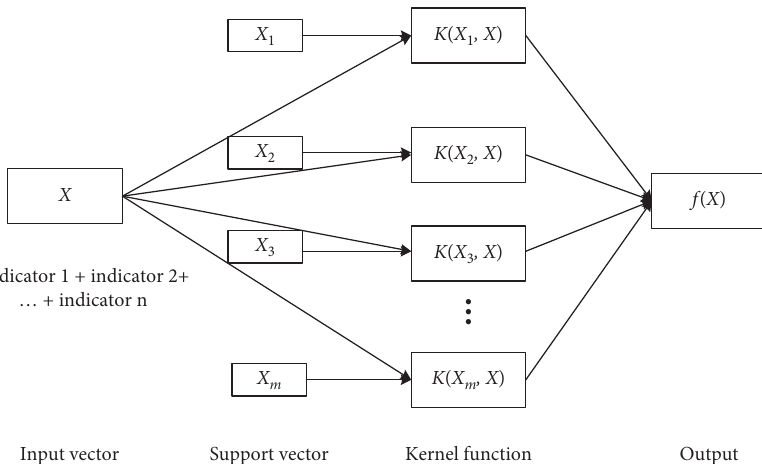
Figure 3: The structure of vehicle fuel consumption prediction model based on support vector regression